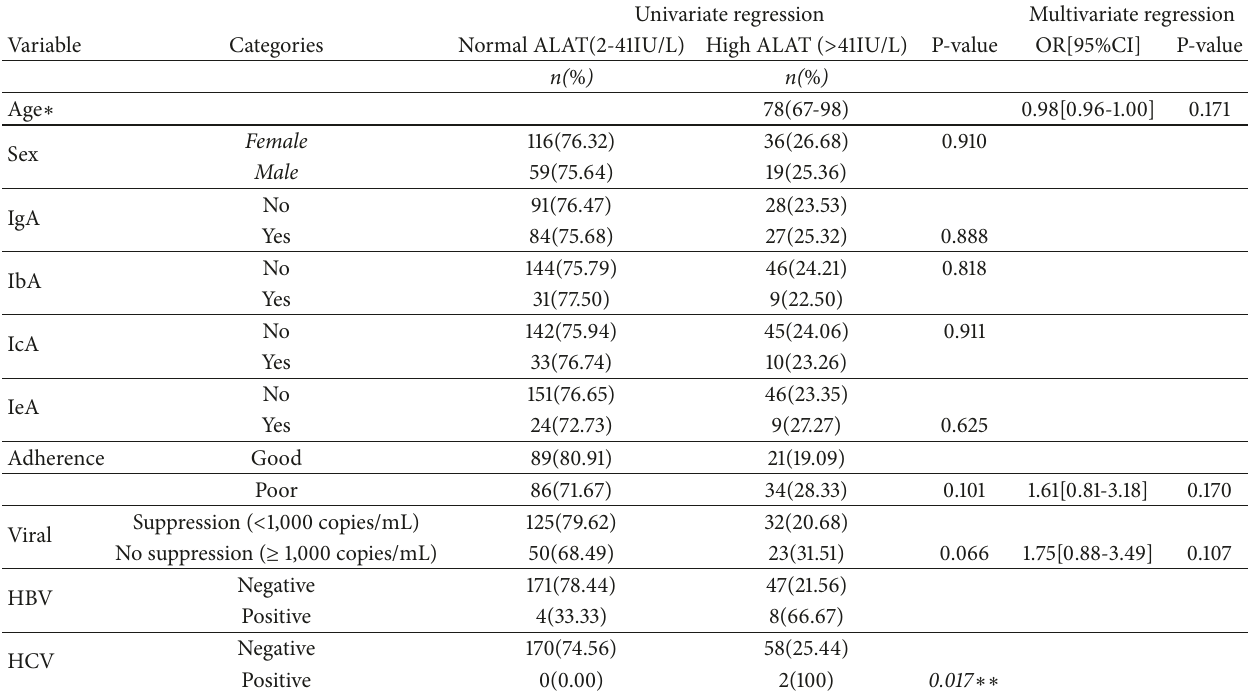
Table 3: Factors associated with high ALAT levels among HIV positive individual in the lake zone (N=230). Univariate regression Multivariate